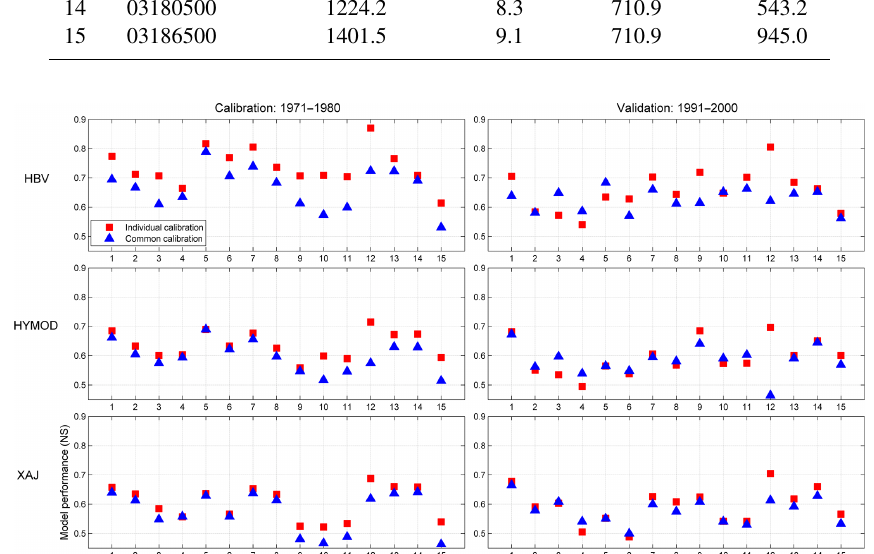
Figure 2. Performance of the individually calibrated and the common calibrated models using NS as performance criterion.